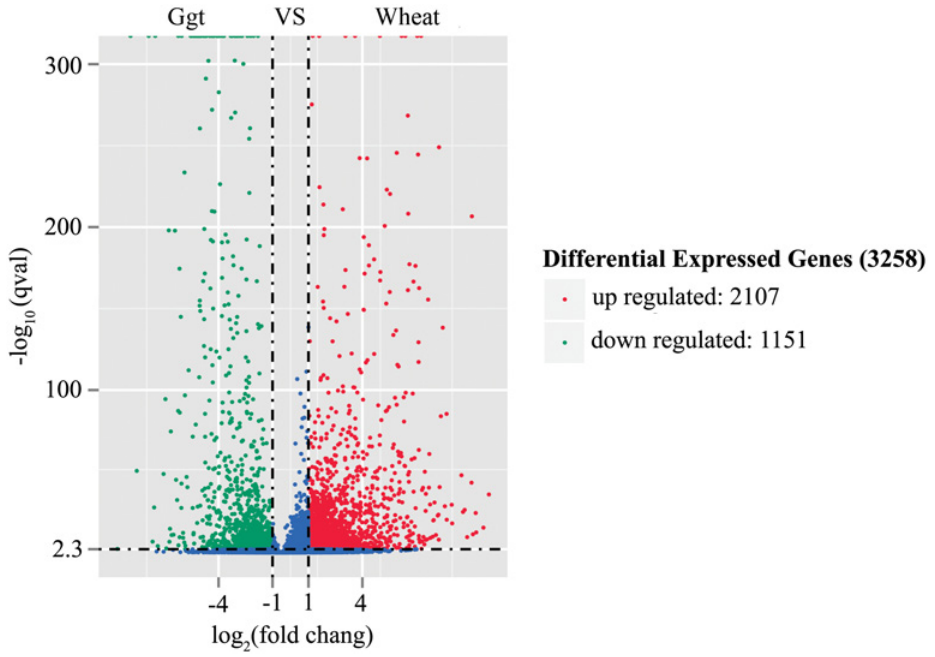
Fig 1. Volcano of DEGs between Ggt culture and Ggt -infected wheat roots. Ggt: Ggt -culture, wheat: Ggt -infected wheat roots; the y-axis corresponds to the mean expression value of log10 (p-value), and the x- axis displays the log2 fold change value. The red dots represent up-regulated DEGs, the blue dots represent down-regulated